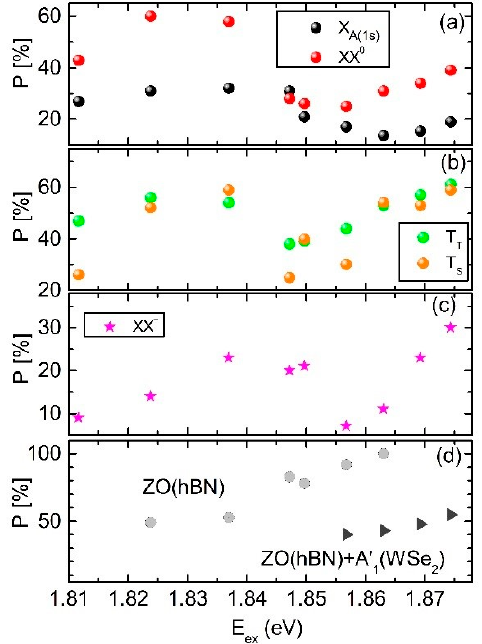
Figure 4. Degree of circular polarization plotted as a function of excitation energy for: ( a ) neutral A exciton (X A ) and biexciton (XX 0 ), ( b ) negative trion in the singlet (T S ) and triplet (T T ) state, ( c ) negatively charged biexciton (XX − ), ( d ) Raman modes ZO (hBN) and ZO (hBN) + A (cid:48) 1 (WSe 2 ). The circular polarization degree of the neutral biexciton XX 0 is about 40% at resonant 3s A exciton excitation, decreases weakly with decreasing excitation energy and reaches a minimum of ~25% when E ex = 1.8631 eV. Interestingly, at this excitation energy the Raman mode ZO (hBN) + A (cid:48) 1 (WSe 2 ) is more intense than the emissions of all